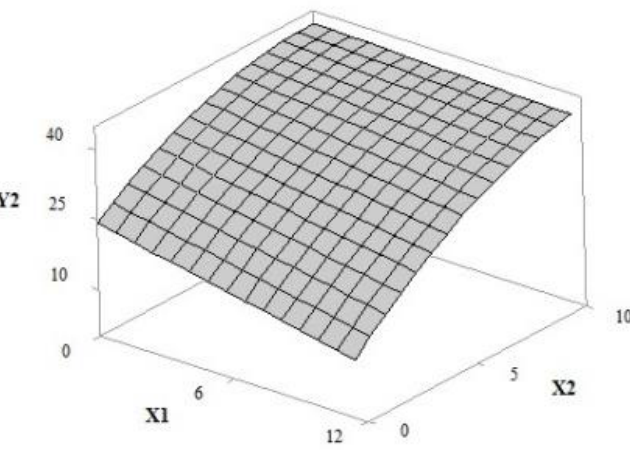
Figure 4. Response surface 3D plot of antioxidant activity — DPPH (Y2) as a function of the concentration of UV filters: butylmethoxydibenzoyl methane — UVA, ethylhexyl methoxycinnamate and ethylhexyl dimethyl PABA — UVB of 0 – 12% w / w (X1) and grape pomace extract concentration of 0 – 10% w / w (X2).